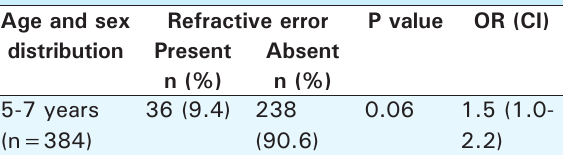
Table 3. Prevalence of refractive error.